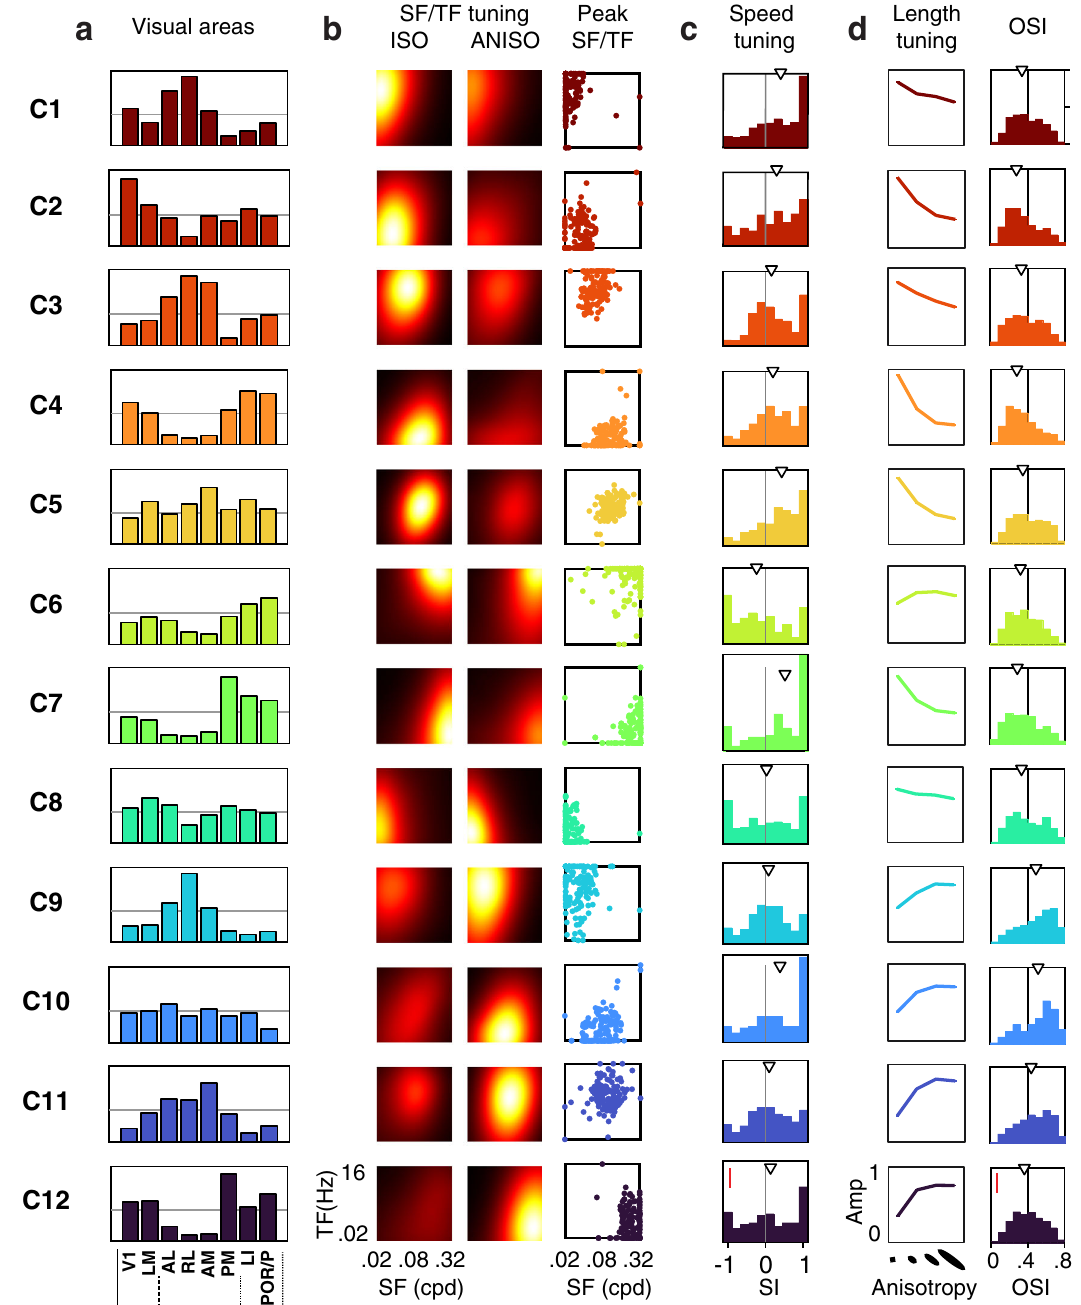
Fig. 7 Unsupervised clustering analysis uncovers the diversity of tuning underlying specialized representations in mouse visual areas. a Non-uniform representations of functional clusters in response to isotropic (ISO) and anisotropic (ANISO) stimuli. Each plots shows the proportions of neurons belonging to one particular functional cluster for each visual area. Unsupervised k-means clustering of responses to noise stimuli yielded 12 functional clusters (dataset 1 & 2, see Methods and Supplementary Fig. 13 for details). The horizontal lines correspond to 10% of cells in each visual area. Proportions obtained from random sampling of 2000 neurons per area. b Distinct spatiotemporal tuning properties across clusters. Left: heat maps show the average of peak-normalized fi ts of the responses to ISO and ANISO stimuli. Right: scatter plots show the distribution of peak frequencies. c Distinct speed tuning properties across clusters. d Distinct orientation tuning properties across clusters. Left: average tuning curves for stimuli of distinct orientation bandwidth (elongation), showing consistency with the preferences for ISO or ANISO stimuli in b . Right: distribution of OSI obtained from dataset 3. Arrowhead: median values. SF: spatial frequency. TF: temporal frequency. SI: speed selectivity index. Red scale bars in c and d : 10% observations to a broader set of visual areas using a broader set of patterns such as selectivity for stimulus speed. Focusing on cortical visual stimuli. Previous large-scale studies of HVAs measured excitatory neurons, using stimuli covering the full spatio- 1-dimensional tuning at a fi xed spatial or temporal frequency 32,37 , temporal frequency spectrum, we found the preferred spatial and which can be suboptimal for measuring neurons ’ spatial and temporal temporal frequencies can differ by as much as 8 fold between selectivity and cannot capture space-time inseparable response visual areas (Fig. 3b, d, h), differences much greater than previously